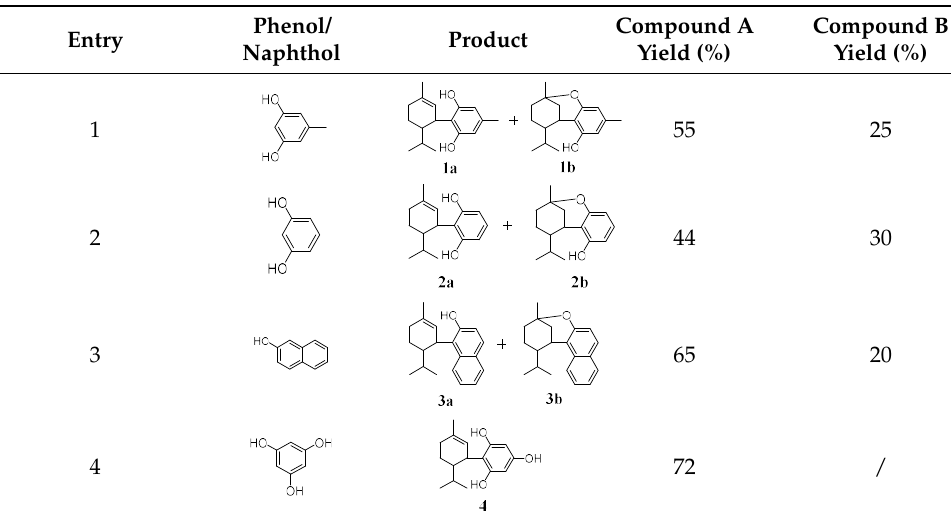
Table 1. Reaction condition screening for H 2 CBD production.